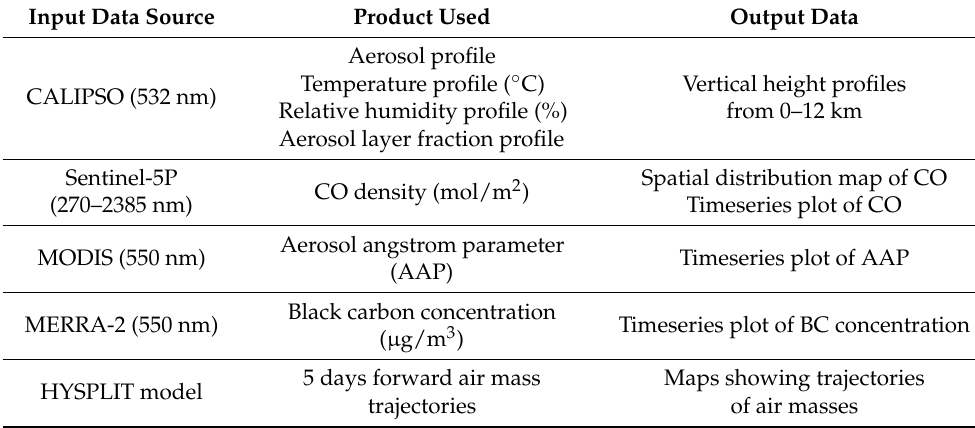
Table 1. Data used to study emissions from